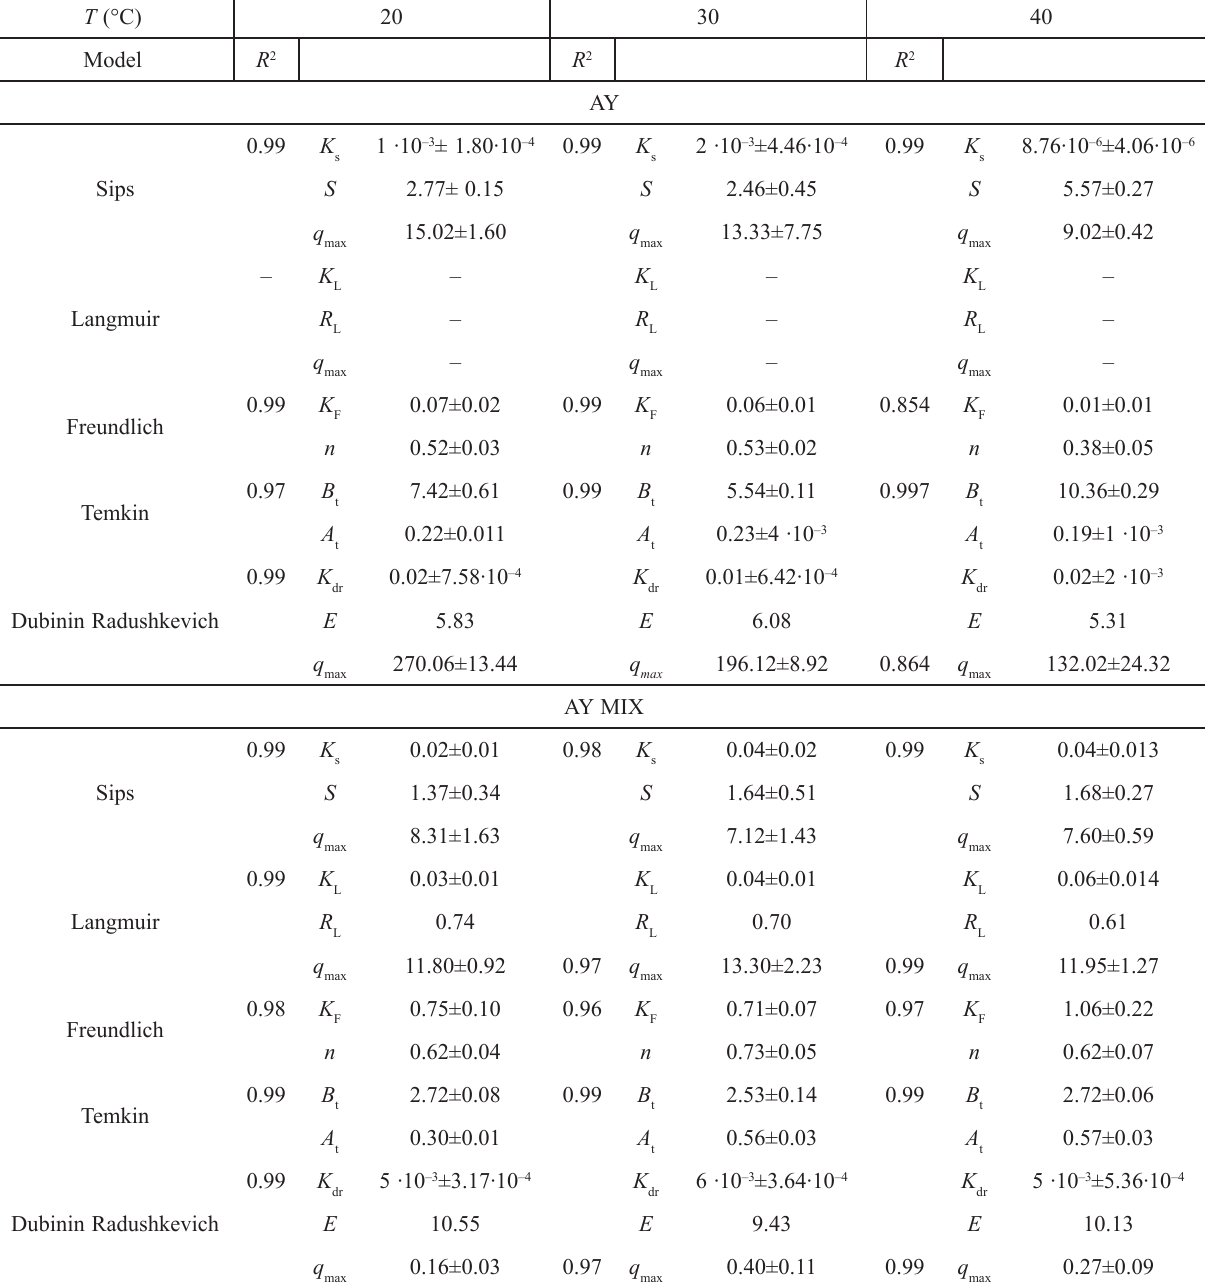
Table 4 – Acid yellow single and binary solutions biosorption isotherm parameters T